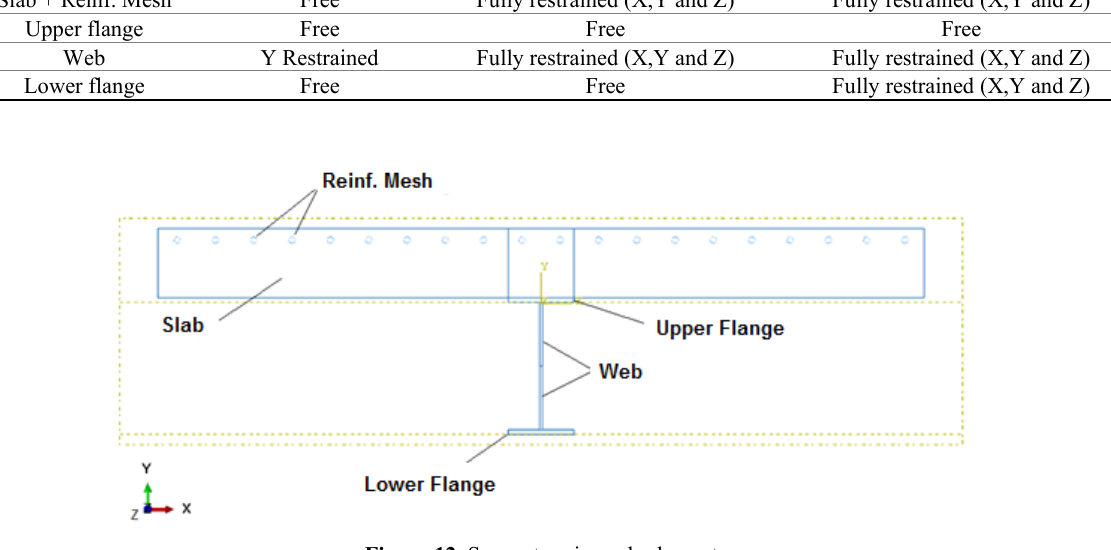
Figure 12. Support region sub-elements.